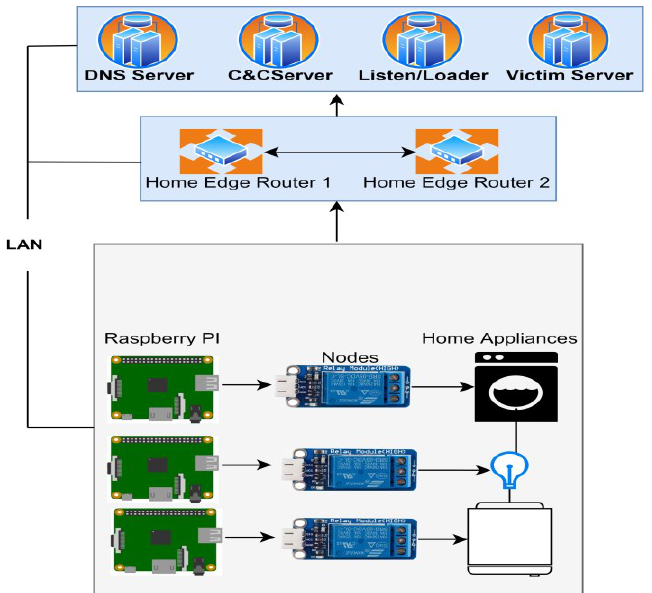
Figure 4. Testbed used in experimenting with the proposed system .